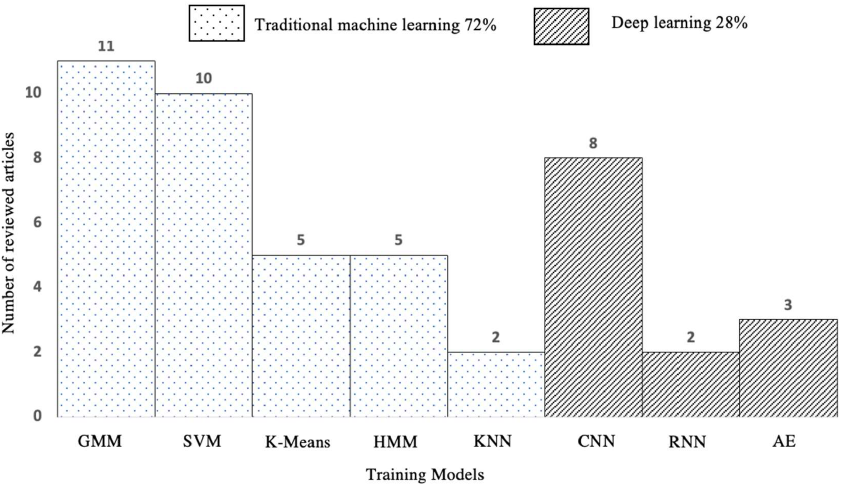
Figure 11. The number of reviewed articles by training